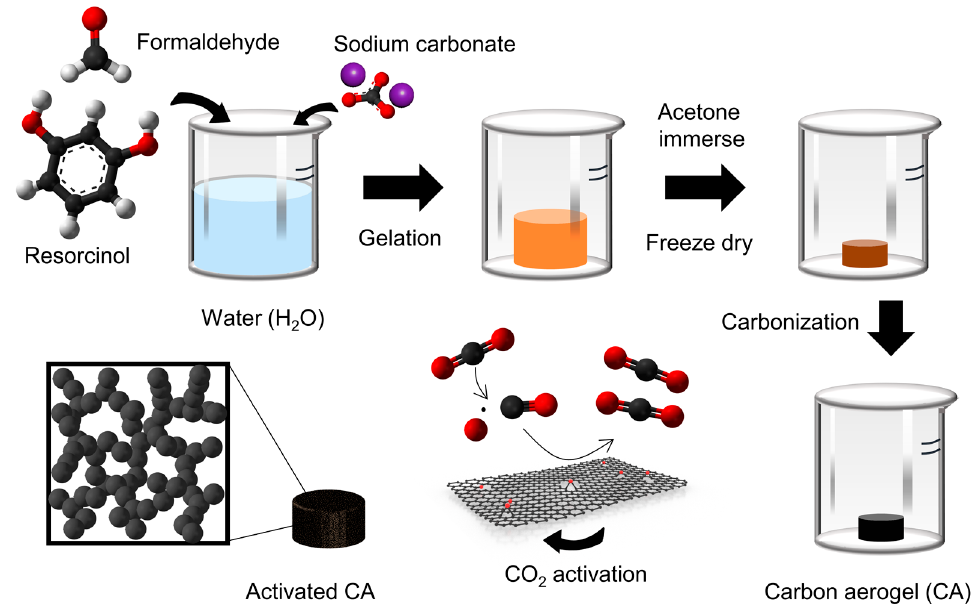
Figure 1. Schematic illustration of the preparation of activated carbon aerogel (ACA) samples.